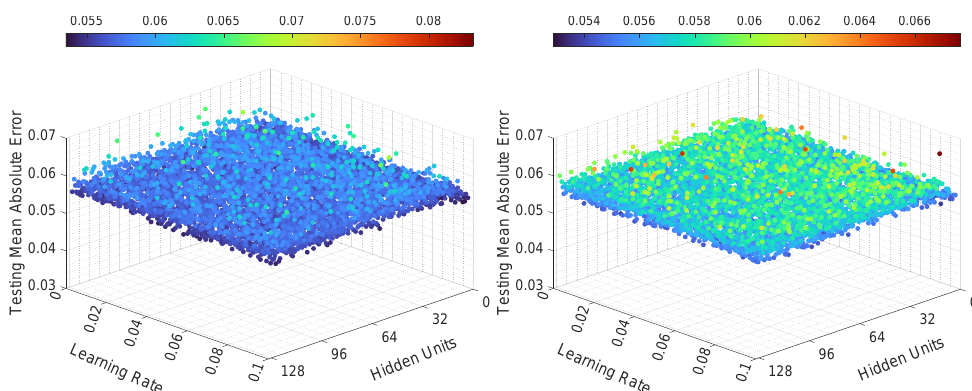
Figure 13. Illustration of the testing mean absolute error value for Experiment 3, LSTMTF ( left ) and VLSTM ( right ), using a many-to-one prediction